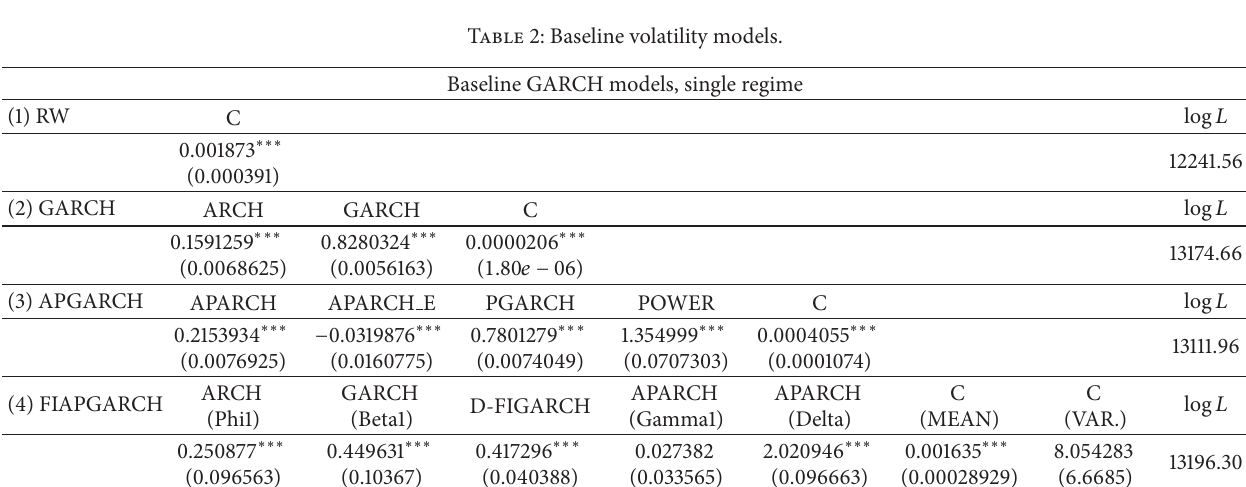
Table 2: Baseline volatility